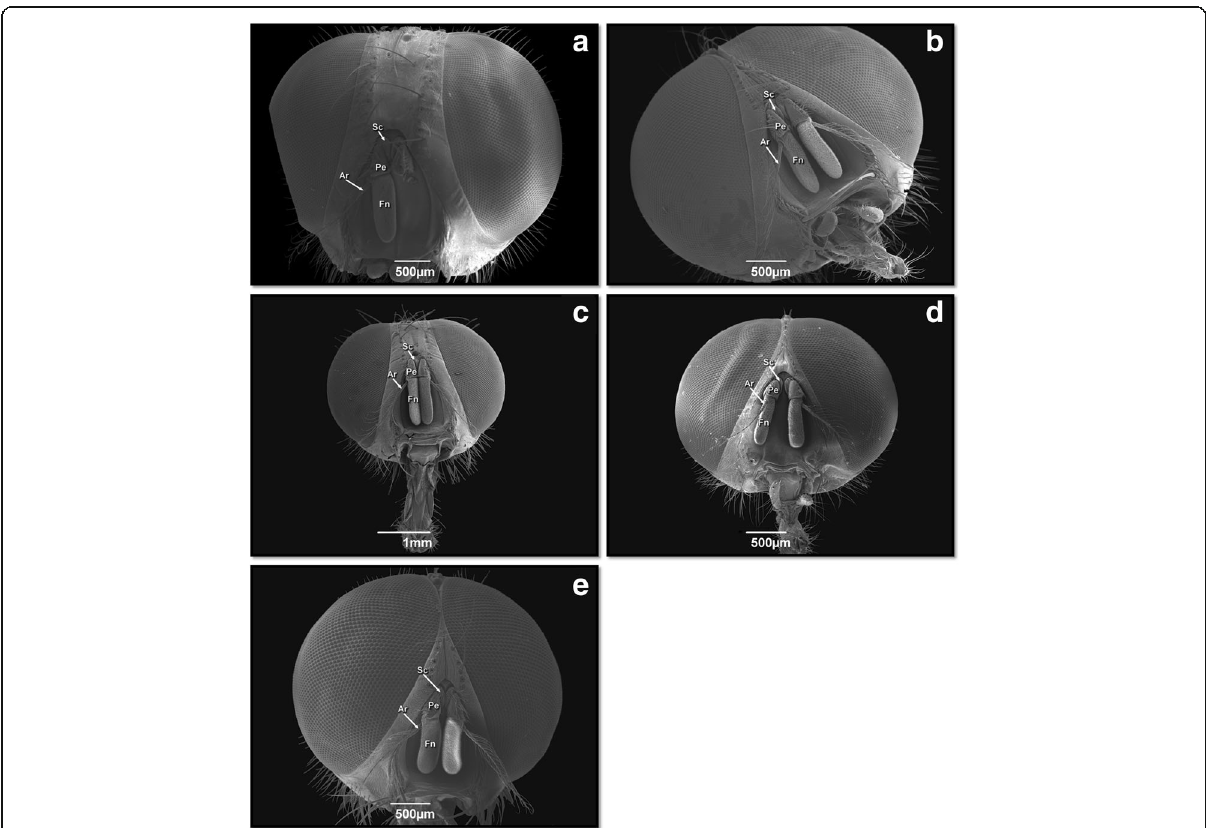
Fig. 1 Scanning electron micrographs showing the heads, in frontal view, of the different species analyzed. Mesembrinella bellardiana : a female (×27), b male (×30). Mesembrinella bicolor : c female (×27), d male (×30). Mesembrinella semihyalina e male (×30). Sc=scape; Pe=pedicel; Ar=arista;